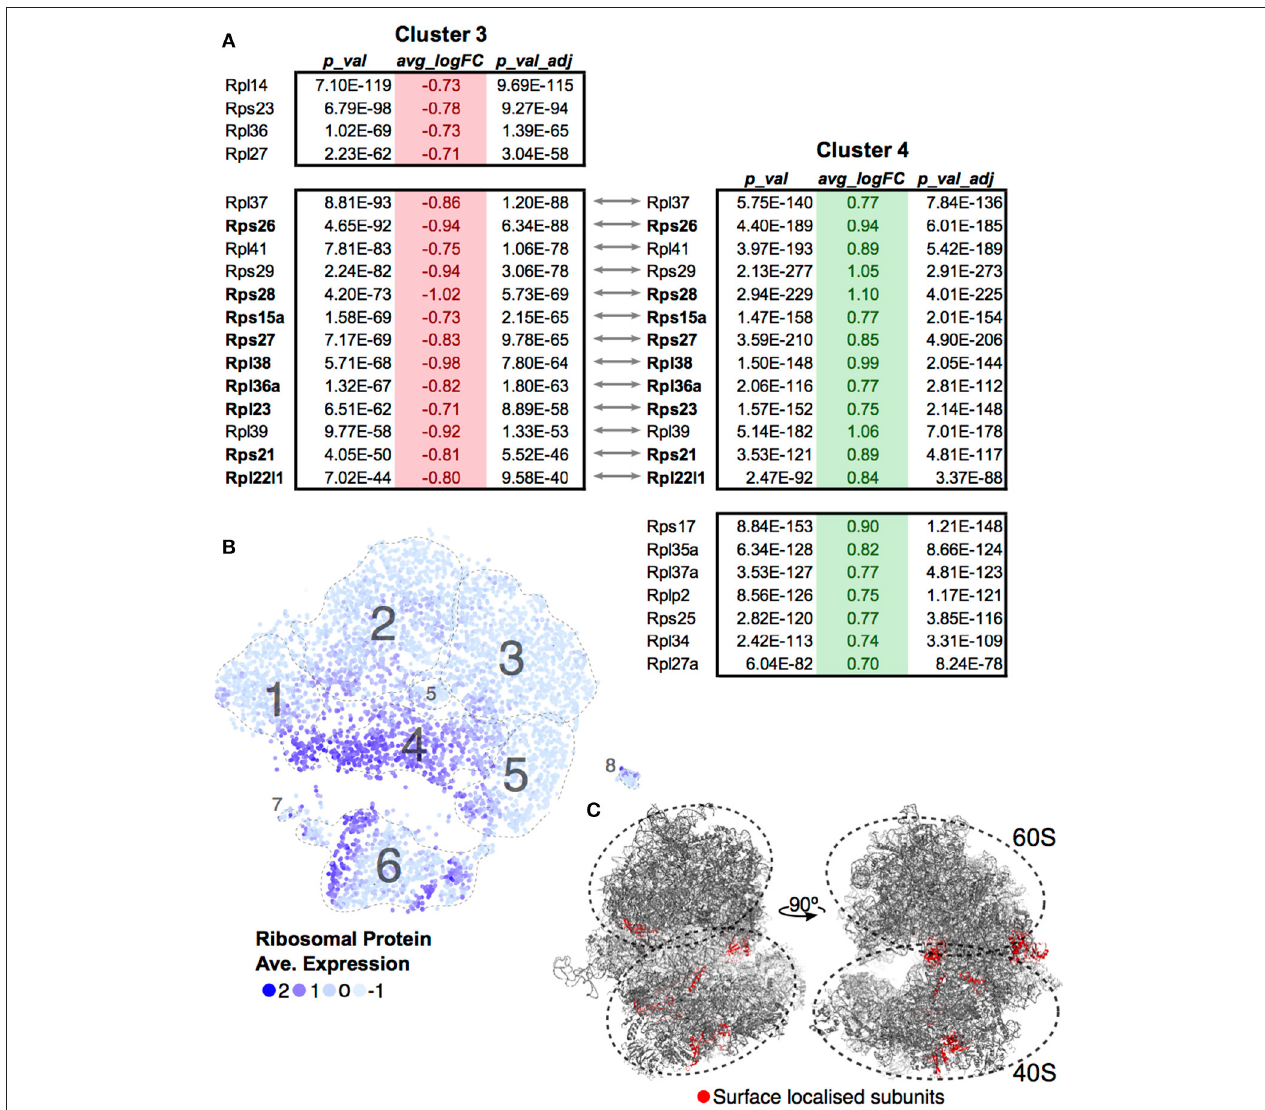
FIGURE 5 | Ribosomal protein transcripts distinguish T-cell maturation steps. (A) Significant changes ( p < 0.01; log 10 Fold Change > 0.7) in ribosomal protein transcripts within Cluster 3 and Cluster 4 were compared. Ribosomal genes in bold code for proteins found on the surface of the ribosome. (B) Ribosomal protein transcript levels are displayed across cells using average expression values for the 13 genes identified by comparing Clusters 3 and 4. (C) Ribosomal genes identified to be localized on the surface of the ribosome are mapped onto the ribosome structure (red, PDB:6EK0). Supplemental Movie 1 visualizes the surface ribosome genes identified on the structure as it rotates on the